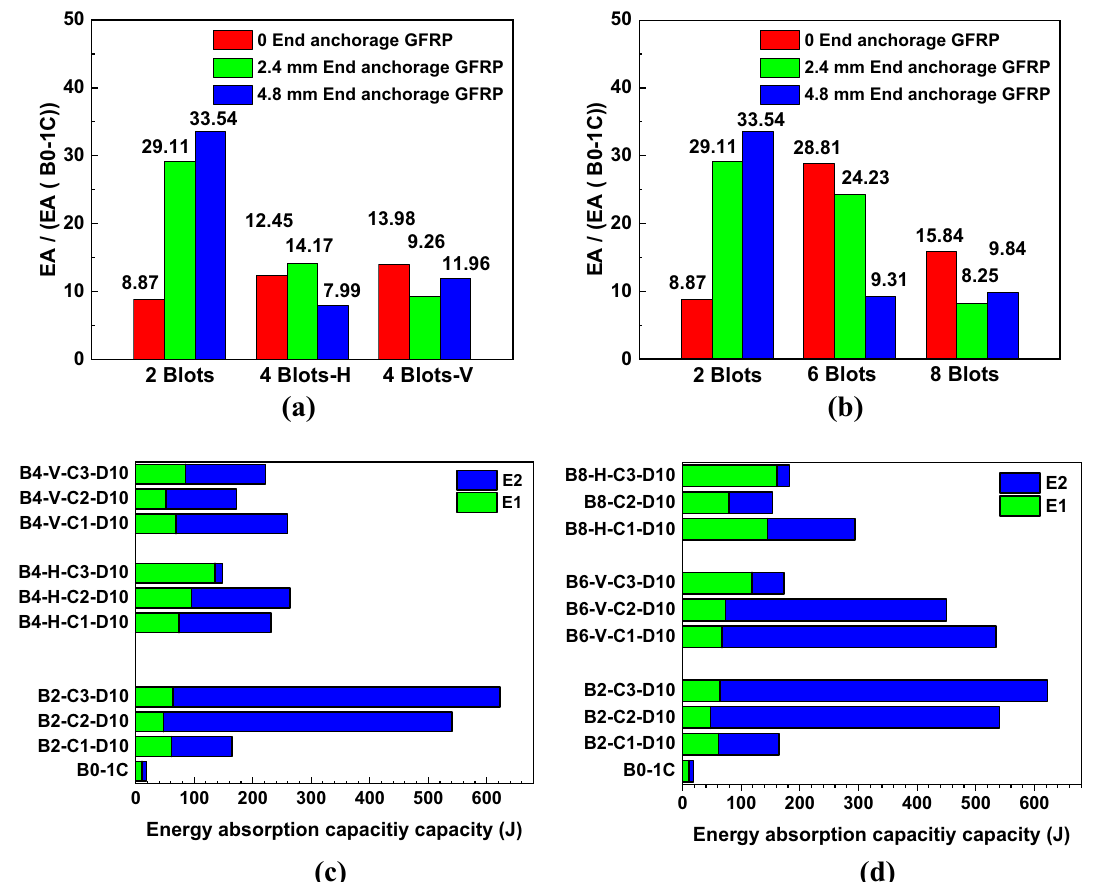
Fig. 13 Energy absorption versus bolt quatity (diameter 10 mm) and end-anchorage thickness: a , b normalized values; c , d detail of pre (E1) and post (E2)-energy